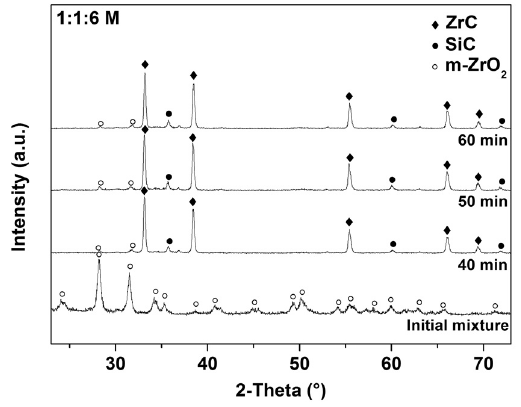
Figure 1: XRD patterns of mixtures prepared in a proportion of 1:1:6 M ratio of Zr:Si:C at 3 kW for different reaction times.